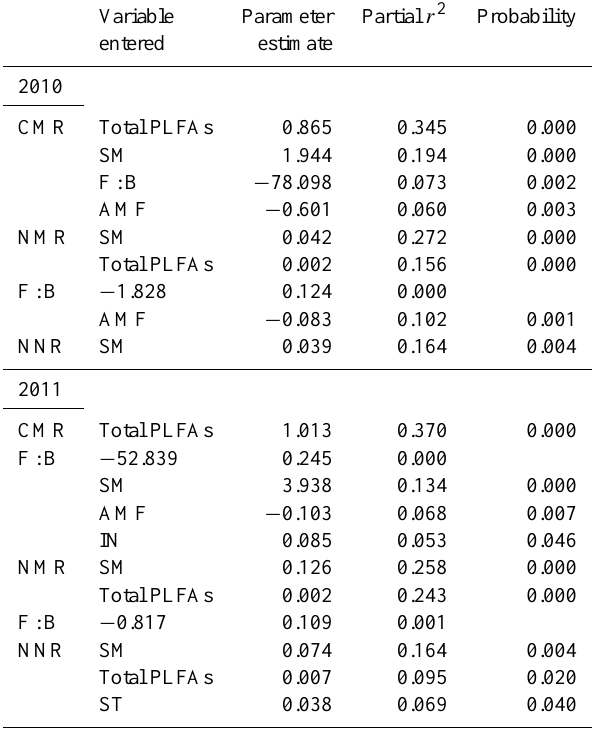
Table 3. Results of stepwise multiple regression analyses. Dependent variables: seasonal mean soil C mineralization rate